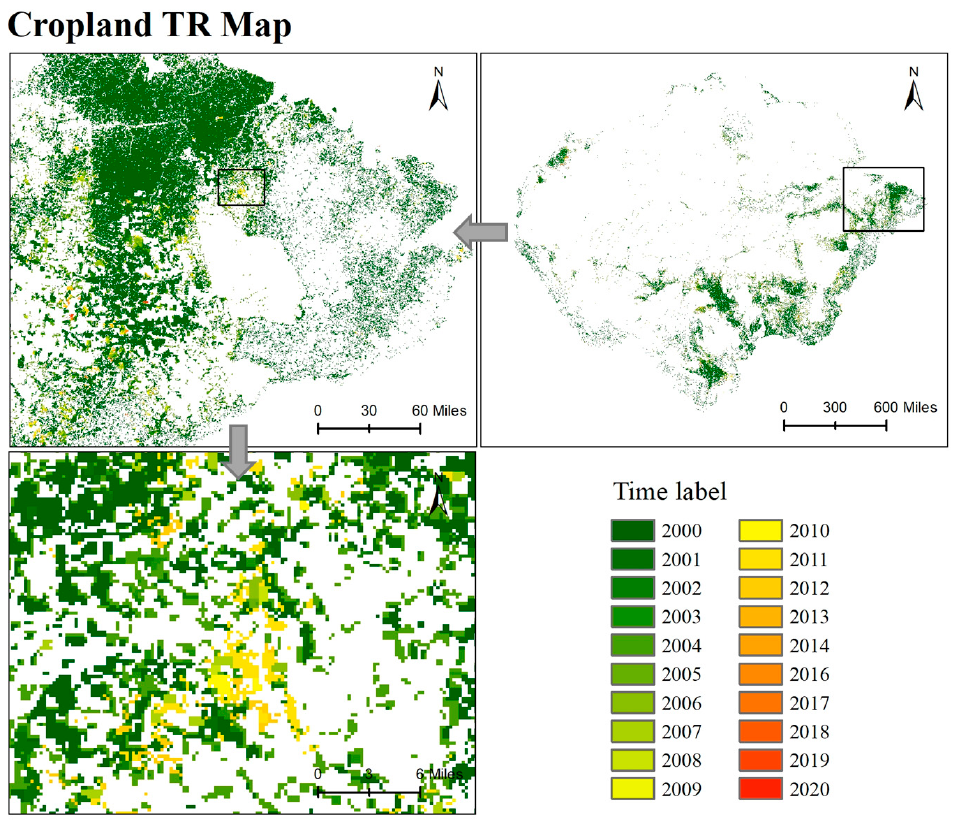
Figure 10. The cropland time ring (TR) map from 2000 to 2020 in the Amazon basin.